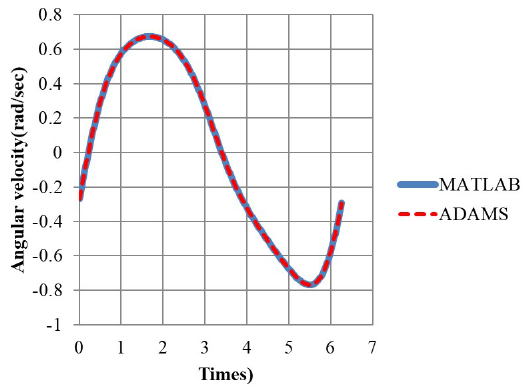
Figure 7. Comparison of our modeling computation with that of ADAMS on ω 4 . Figure 7. C omparison of our modeling computation with that of ADAMS on 4  . Figure 7. C omparison of our modeling computation with that of ADAMS on 4  .